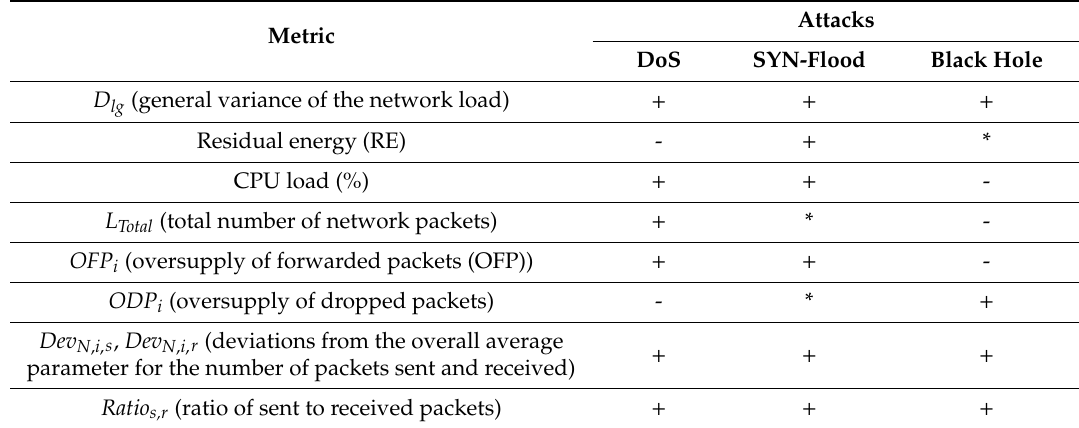
Table 5. Metrics for detecting attacks and evaluating their e ff ectiveness. Attacks Metric DoS SYN-Flood Black Hole D lg (general variance of the network load) + + + Residual energy (RE) - + * CPU load (%) + + - + * - -